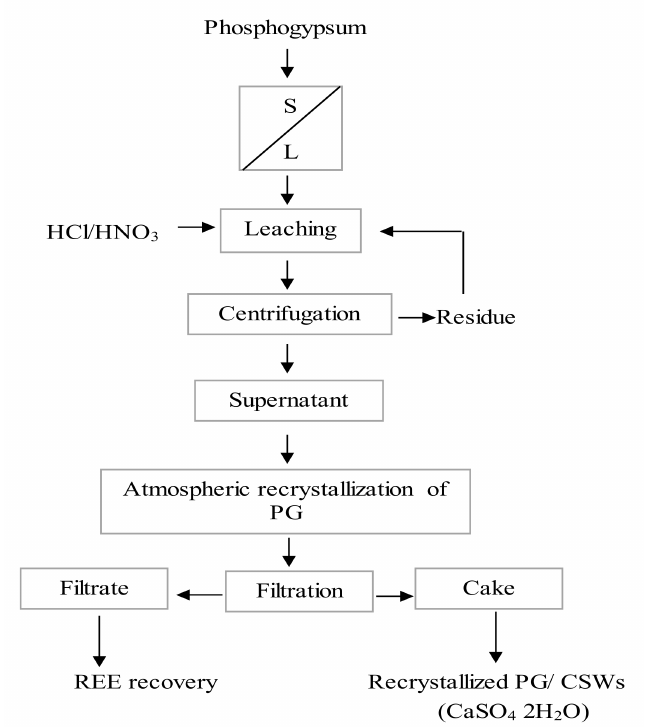
Figure 3. Proposed flowsheet of an atmospheric acid recrystallization of PG with subsequent extrac- tion of